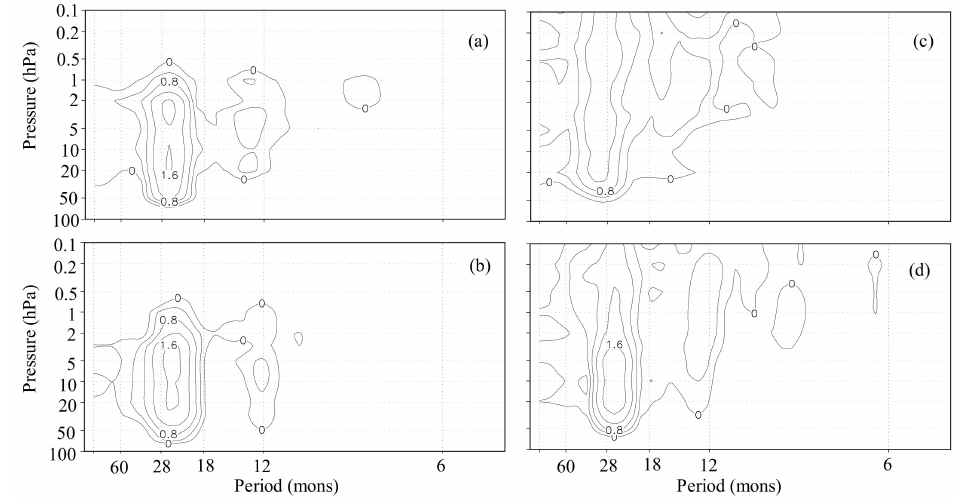
Figure 7. Time–height cross-sections of zonal–mean-zonal wind anomalies (ms − 1 ) averaged between 10 ◦ S and 10 ◦ N in the tropical stratosphere (100–5 hPa) for the perpetual runs of ( a ) January, ( b ) July, ( c ) April, and ( d ) October. Contours interval is 5 ms − 1